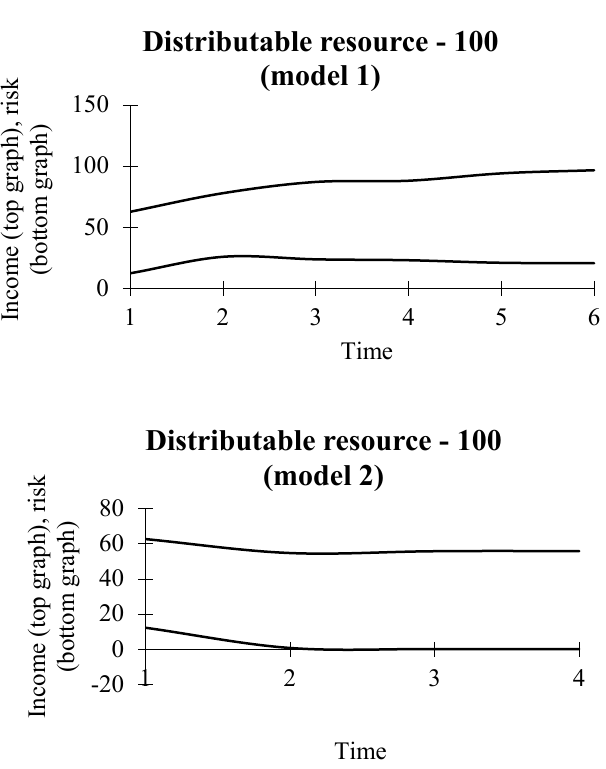
Figure 5. Dynamics of income and portfolio risk for model 1 ( above ) and model 2 ( below ) with an allocated resource of 100 units.